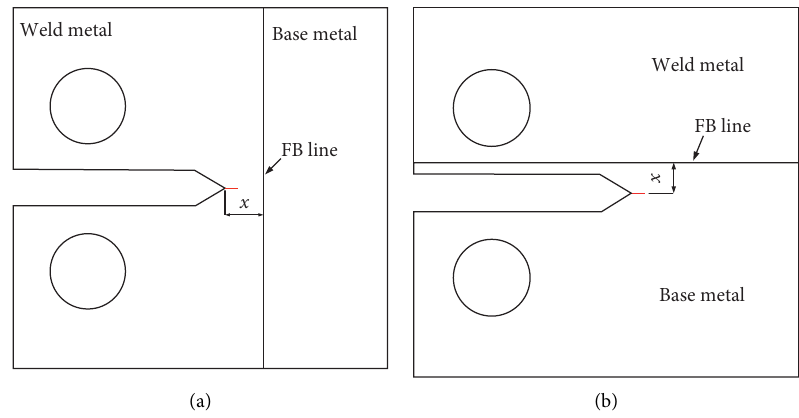
Figure 6: Geometrical model of 0.5T-CT specimen. (a) With a transverse crack and (b) with a longitudinal crack.